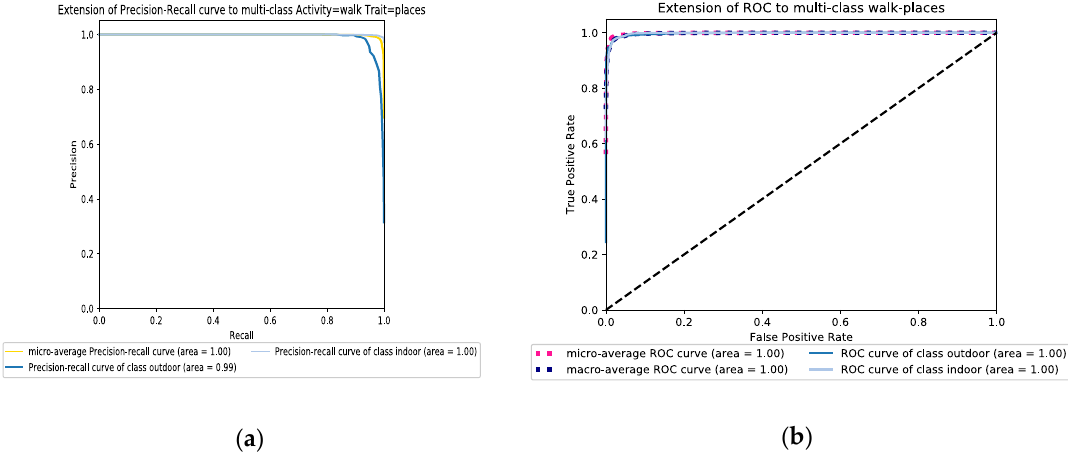
Figure 5. ( a ) The precision-recall performance and ( b ) the ROC graph of walk activity dataset for the Random Forest model in the combined accelerometer and gyroscope datasets scenario.